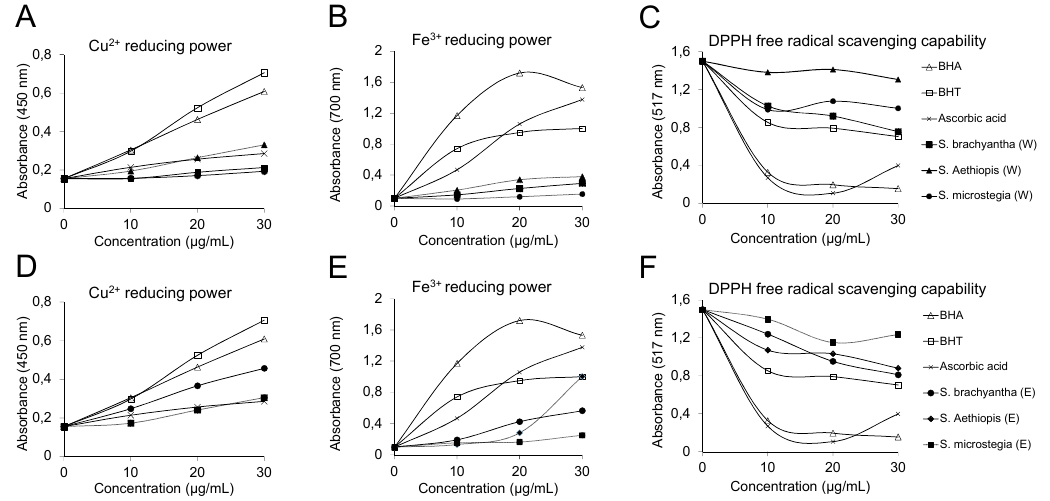
Figure 2. Antioxidant activities of three Salvia species and standards using ( A , D ) CUPRAC assay; ( B , E ) FRAP assay; and ( C , F ) DPPH assay ( E : ethanolic extract, W : water extract).